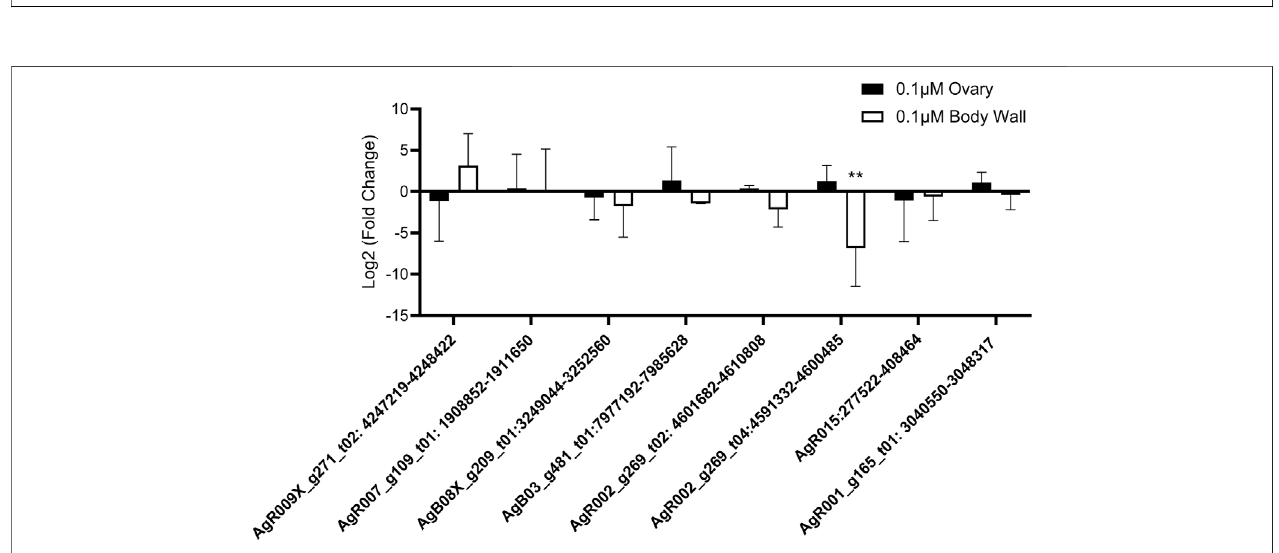
FIGURE 6 | Ivermectin (IVM) treatment has no global effect on circRNA expression in Ascaris suum tissues. Individual adult female A. suum parasites were treated with IVM for 24 h in culture before ovary-enriched and body wall tissues were extracted for circRNA expression analysis using qRT-PCR. C t values were normalized to 40 ng exogenous spike in RNA using 2 − ΔΔ Cq . N = 4 (minimum), mean ± SEM, p ≤ 0.05 considered signi fi cant (** p ≤ 0.01).